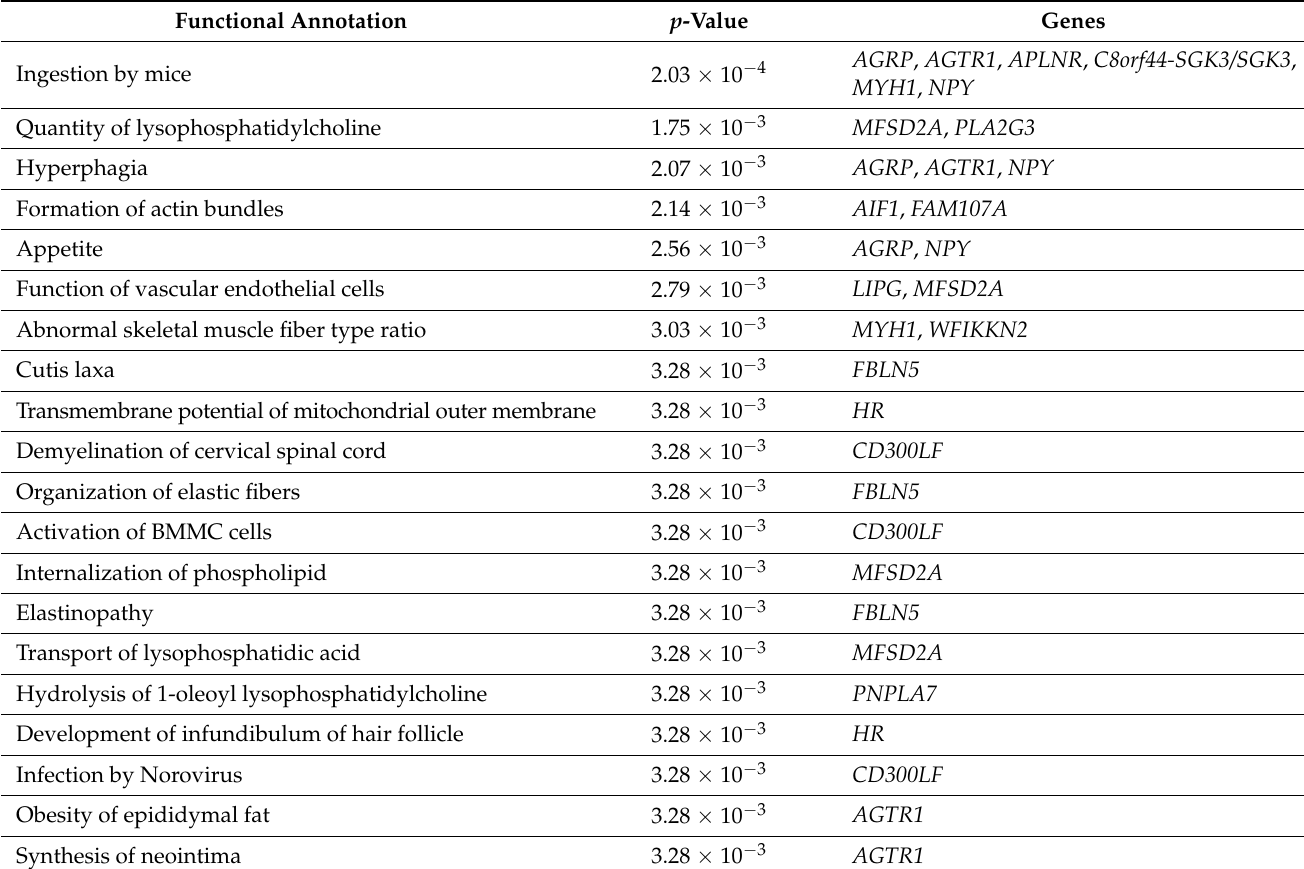
Table 2. Top 20 enriched functional annotations of differentially expressed genes in fasted mice com- pared with those of fed mice. The top 20 of 199 ( p < 0.05) in enriched functional annotation categories are exhibited. Ingenuity pathway analysis software (IPA) was used to analyze enriched functional annotations with an input of 70 DEGs in only the hypothalamus (FDR ≤ 0.05 and abs(log2FC) >